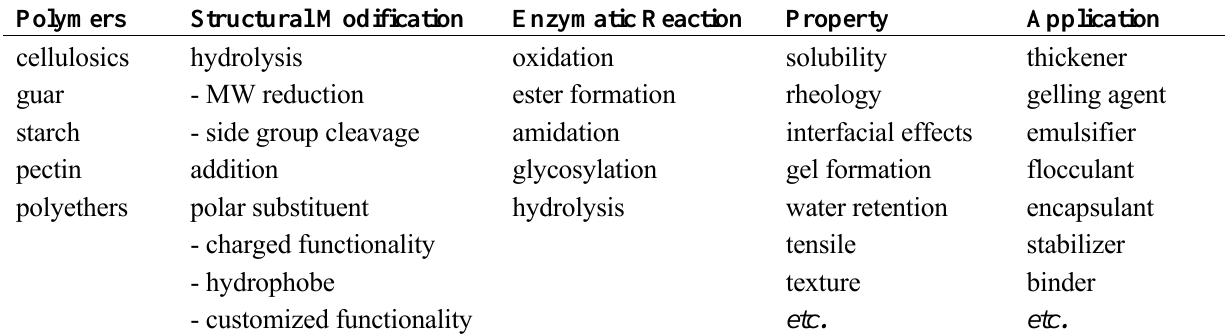
Table 1. Typical water-soluble polymers and modification